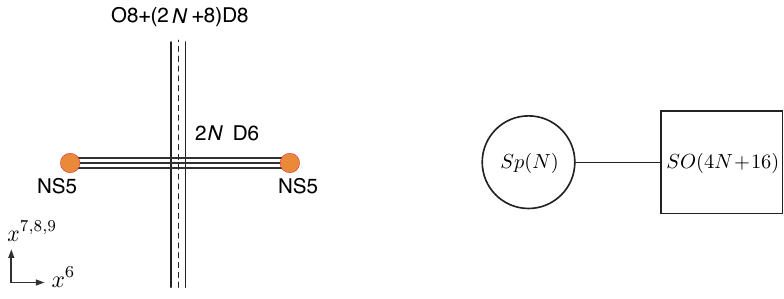
Figure 1 . Left: type IIA brane realization of the ( D tensor branch. Right: the quiver diagram of the 6d